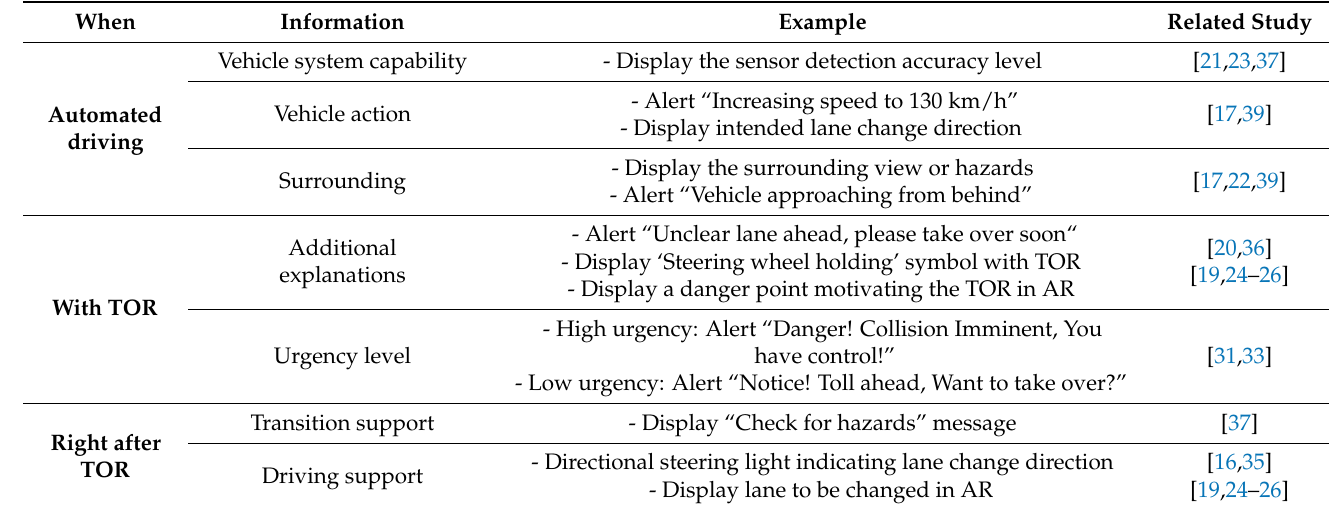
Table 4. Example information types in advanced